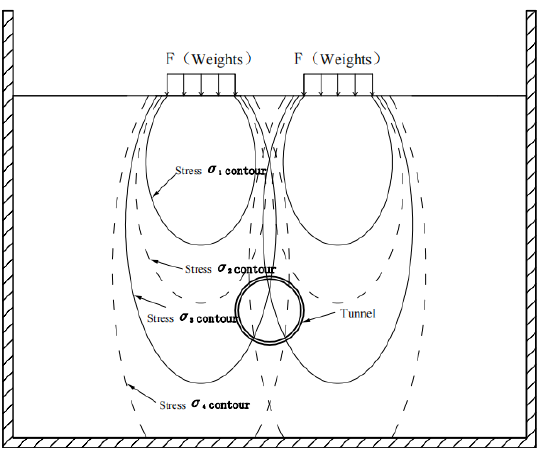
Figure 22. Stress σ contour of dry sand at surcharge on two sides.